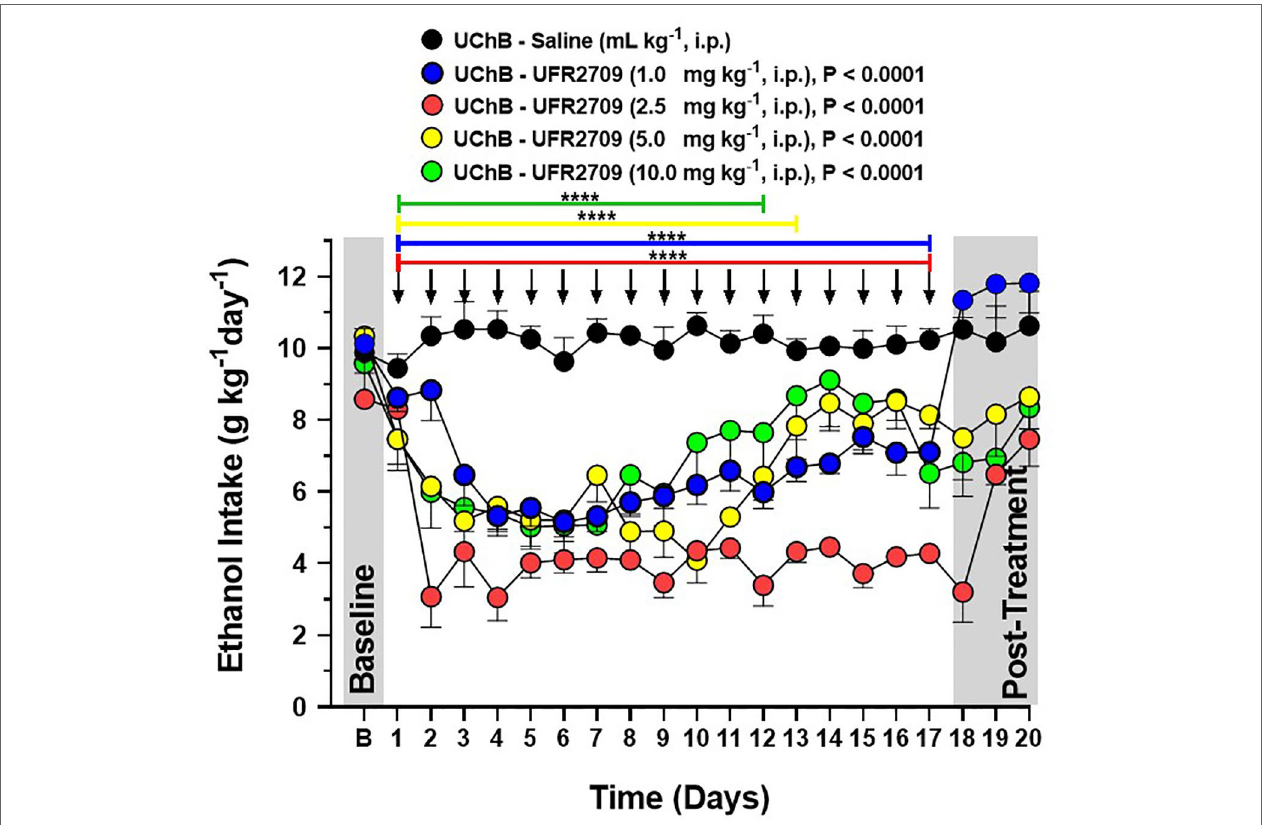
FIgURE 1 | Influence of 17 days of UFR2709 treatment on the voluntary ethanol intake of high-alcohol-drinking UChB rats under a 24-h access two-bottle free choice paradigm. The baseline ethanol consumption of each experimental group is the average ethanol intake during the last 3 days before the treatment period. For 17 consecutive days, rats (n = 5 per group) were administered a single i.p. injection of UFR2709 (1, 2.5, 5, or 10 mg/kg/day) or saline (1 mL/kg/day) at 15:00 h, and ethanol consumption was recorded at 14:00 h the next day. Ethanol consumption data are expressed as mean ± SEM (g/kg/day). Two-way ANOVA with Tukey’s multiple comparison test was used to analyze the effect of UFR2709 treatment on ethanol consumption (P < 0.0001). Arrows indicate the time points of UFR2709 (1, 2.5, 5, or 10 mg/kg) or saline (1 mL/kg) administration via i.p. injection. ****0.0001.